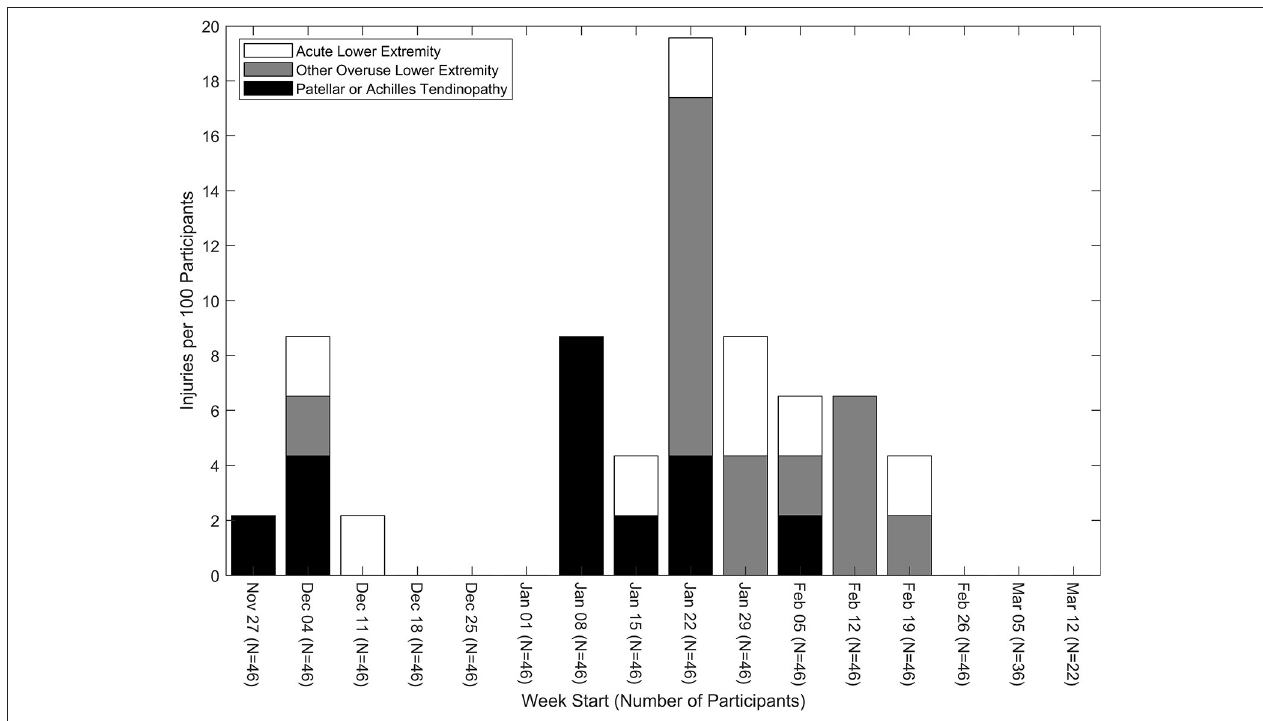
FIGURE 1 | Number of injuries in each injury classification per 100 participants for each week of the season.